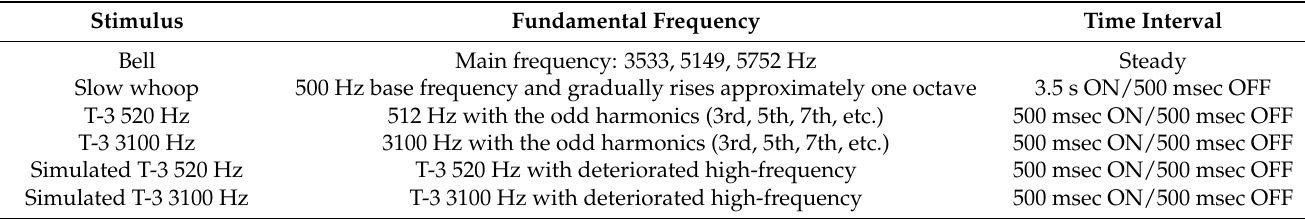
Table 2. Six different types of fire alarm sounds used in the present study and their acoustic characteristics.